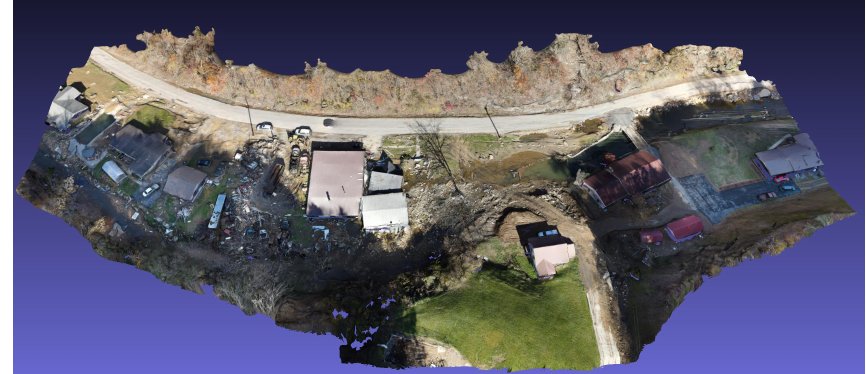
Figure 4. 3D reconstruction of a portion of Guesses Fork Road in Hurley, Virginia.